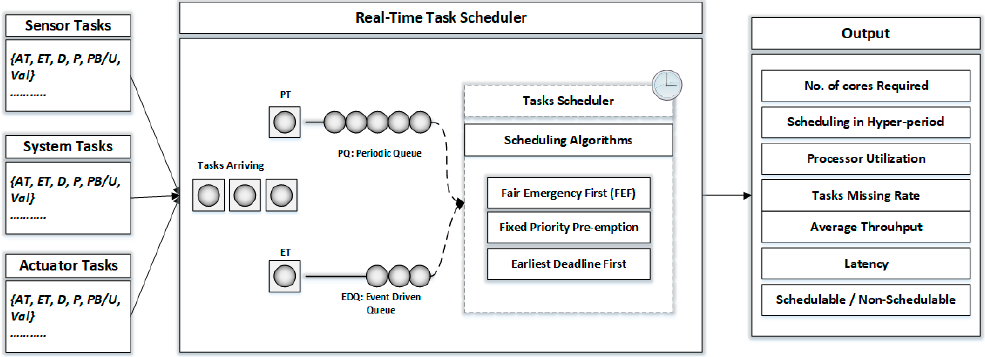
Figure 3. Scheduling model.